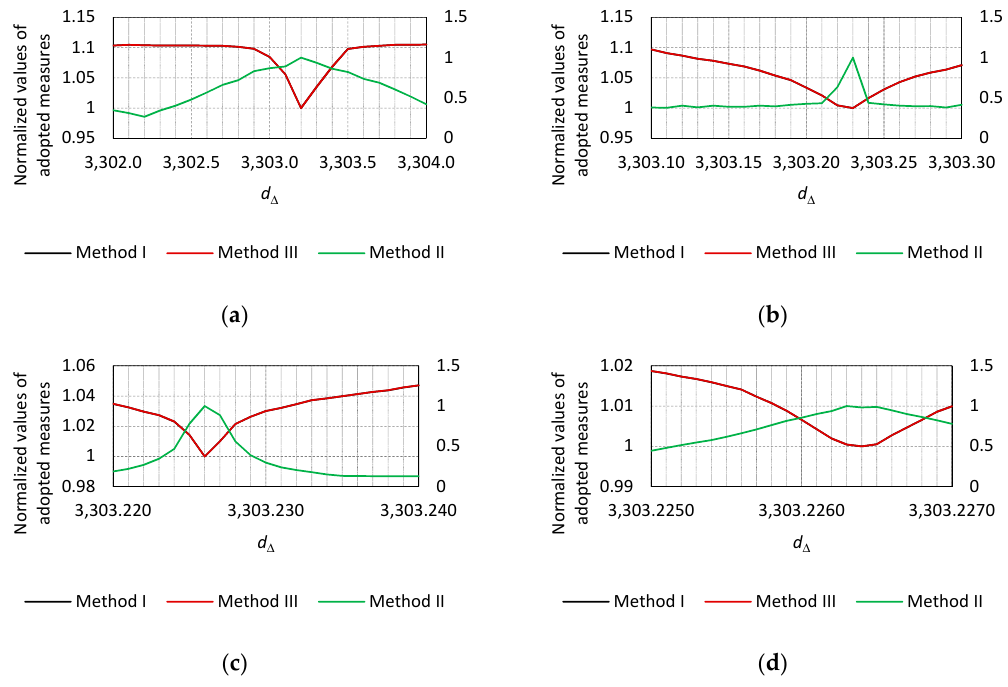
Figure 31. The normalized values of the adopted measures (method I, II and III) calculated in domain of image line length d ∆ for the accuracy ( a ) ∆ = 0.1, ( b ) ∆ = 0.01, ( c ) ∆ = 0.001 and ( d ) ∆ = 0.0001 (for the original image shown in Figure 7e).